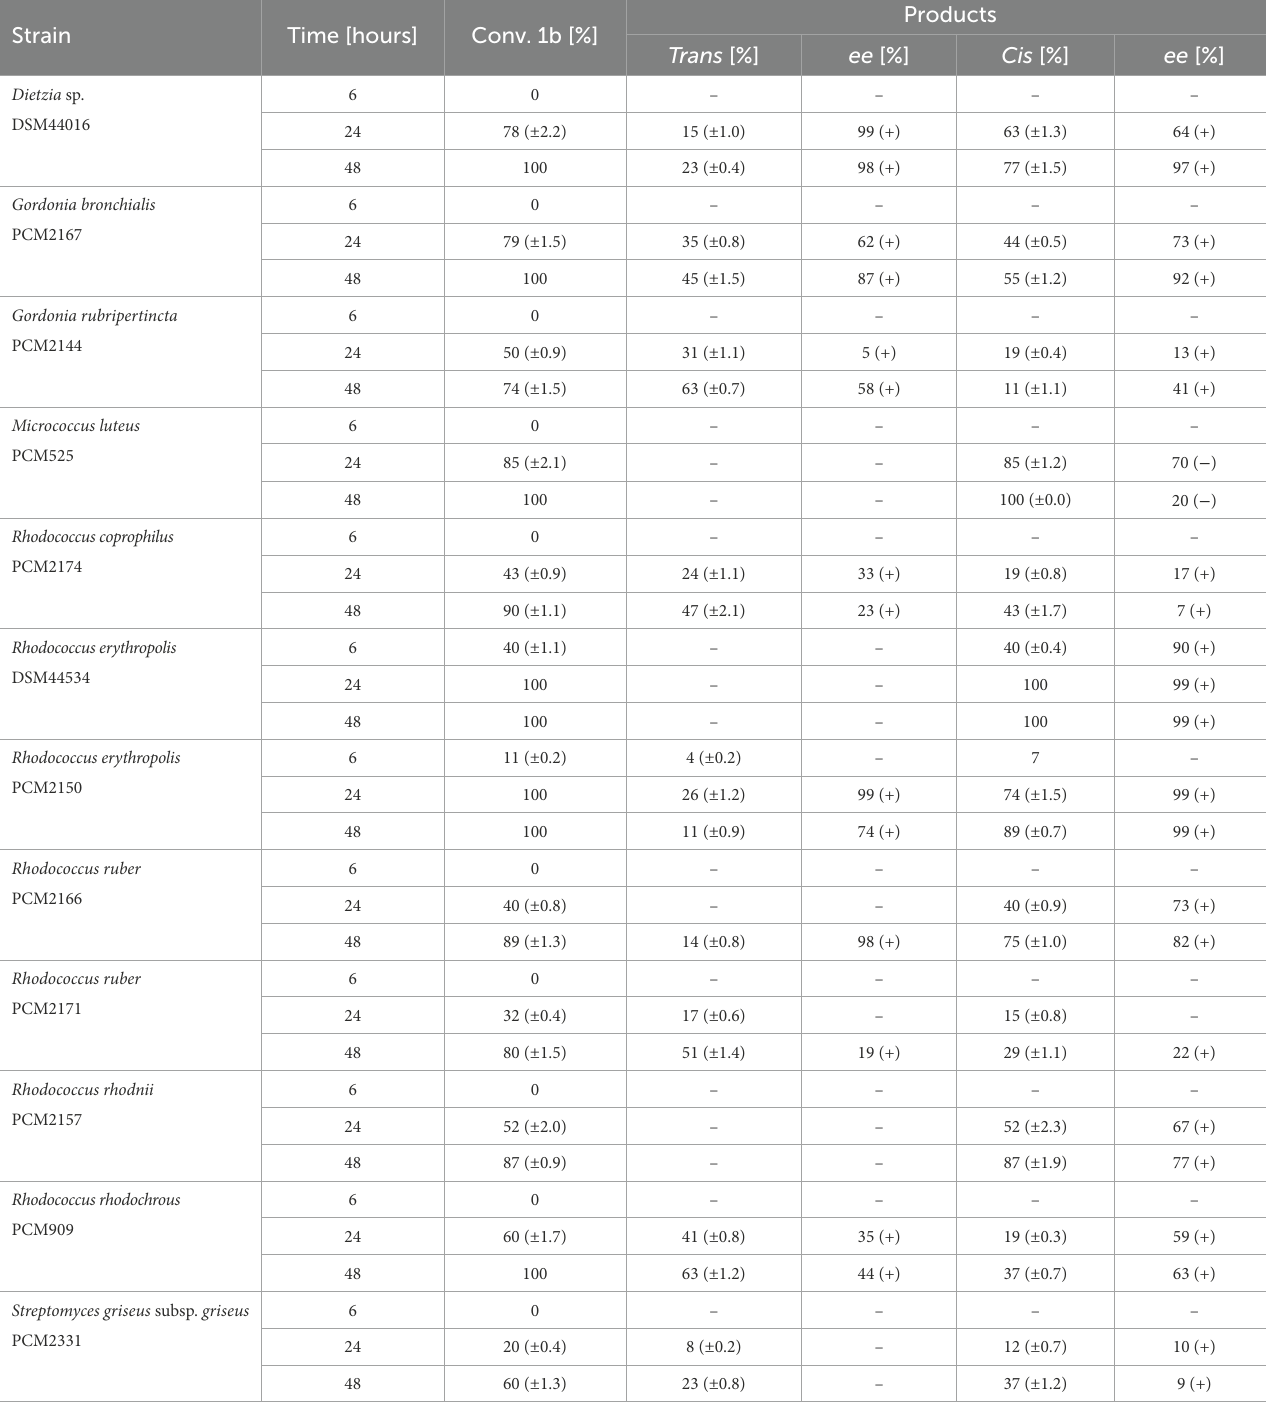
TABLE 2 Results of the microbial oxidation of syn -3-methyloctane-1,4-diol (1b) in MTPs.